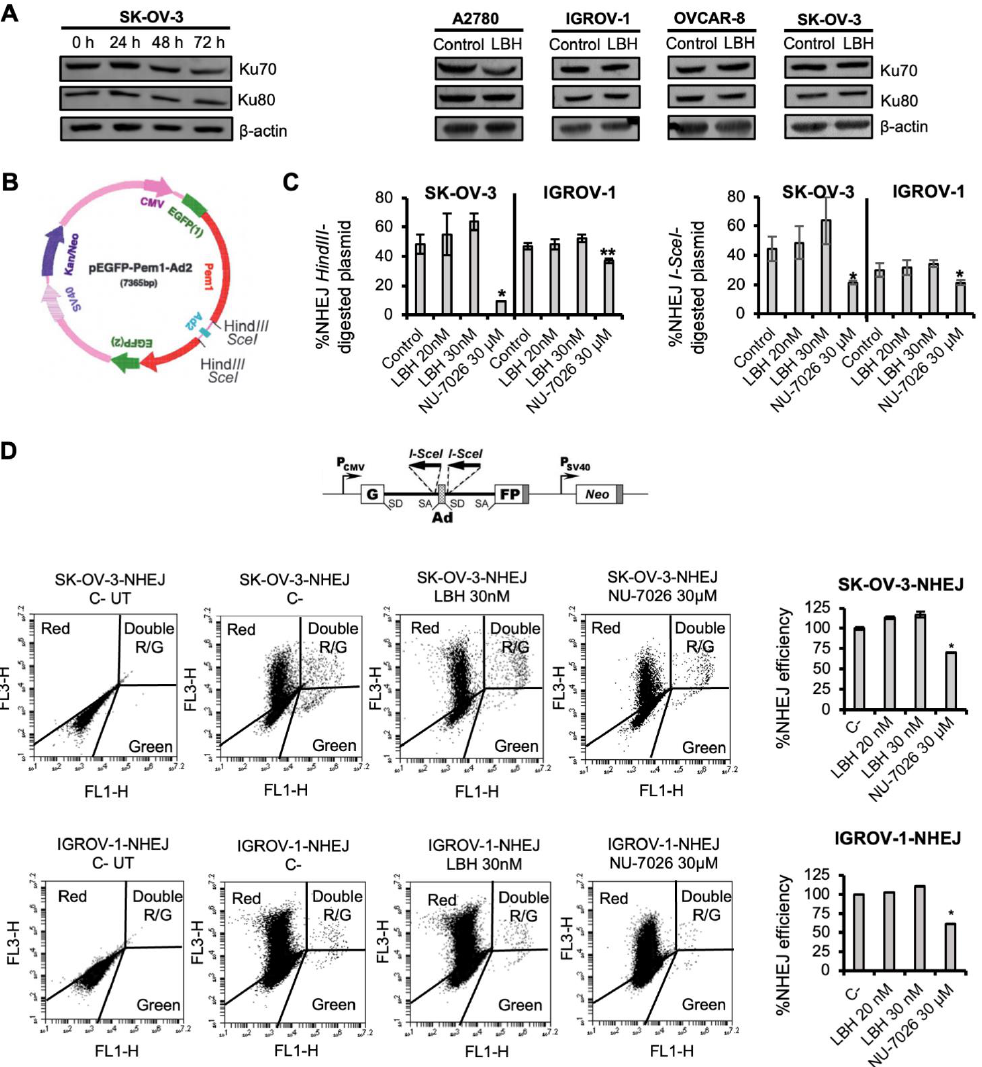
Figure 1. Panobinostat does not affect DSB repair by NHEJ. ( A ) Left panel: time-response of NHEJ- related proteins (Ku70, Ku80) after LBH treatment (50 nM) in SK-OV-3 cell line. Right panel: Ku70 and Ku80 expression after 24 h of LBH treatment (20 nM) in OCCLs. β -actin was used as a loading control. ( B ) Map of pEGFP-Pem1-Ad2. An Ad2 exon is present in the middle of the Pem1 intron, and efficient splicing inactivates the GFP activity and makes the starting substrate GFP-negative. However, both sides of the Ad2 exon present HindII/I-SceI restriction sites. Cleavage with either of these endonucleases removes the Ad exon, and upon successful intracellular plasmid circularization, GFP expression is restored and can be quantified by flow cytometry [47]. ( C ) Percentage of NHEJ using HindIII - or I-SceI -digested plasmid in IGROV-1 and SK-OV-3 cell lines. Cells were pre-treated or not with the indicated doses of LBH or NU-7026, transfected with the linearized pEGFP-Pem1-Ad2 or supercoiled pEGFP-Pem1 together with the pDSRed plasmid, and incubated again with LBH or NU-7026 for 72 h. The percentage of NHEJ was calculated as described in the Materials and Methods. ( D ) Top panel: Map of NHEJ-C reporter construct [48]. Bottom panel: Dot plots of nontransfected SK-OV-3 and IGROV-1 cells carrying the NHEJ reporter cassette, and the same cell lines co-transfected with 5 µ g of an I-SceI endonuclease-expressing plasmid and 0.5 µ g of pDsRed2-N1. The latter were incubated in the presence or absence (C-) of LBH or NU-7026 for an additional 72 h. Correct NHEJ repair restored the GFP gene, which was detected as GFP+ cells. NHEJ efficiency was calculated as the ratio of GFP+ to DsRed+ cells and then normalized to the untreated control. C-: negative control (untreated cells). Data are the mean of three independent experiments. Error bars represent the SD (** p < 0.01, * p < 0.05 compared to